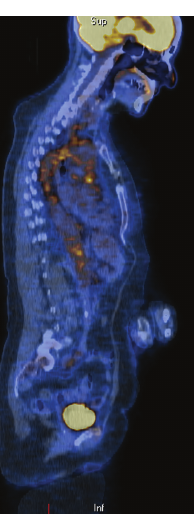
Figure 2: PET scan image showing hot spots in the central large vessels.